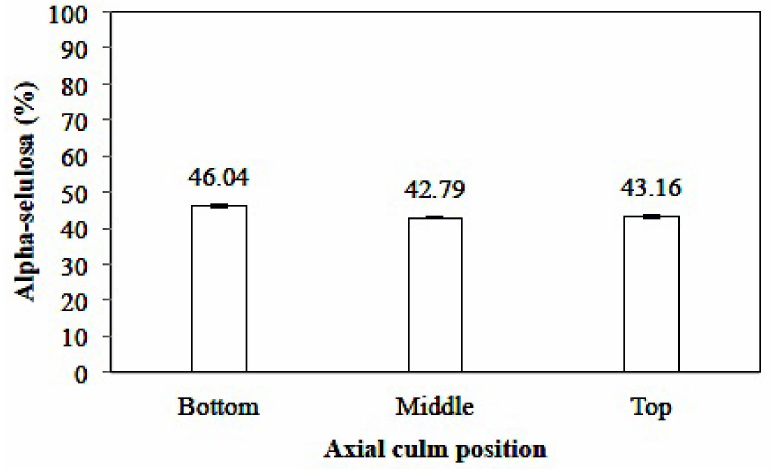
Figure 9. The alpha-cellulose contents of Gigantochloa pruriens